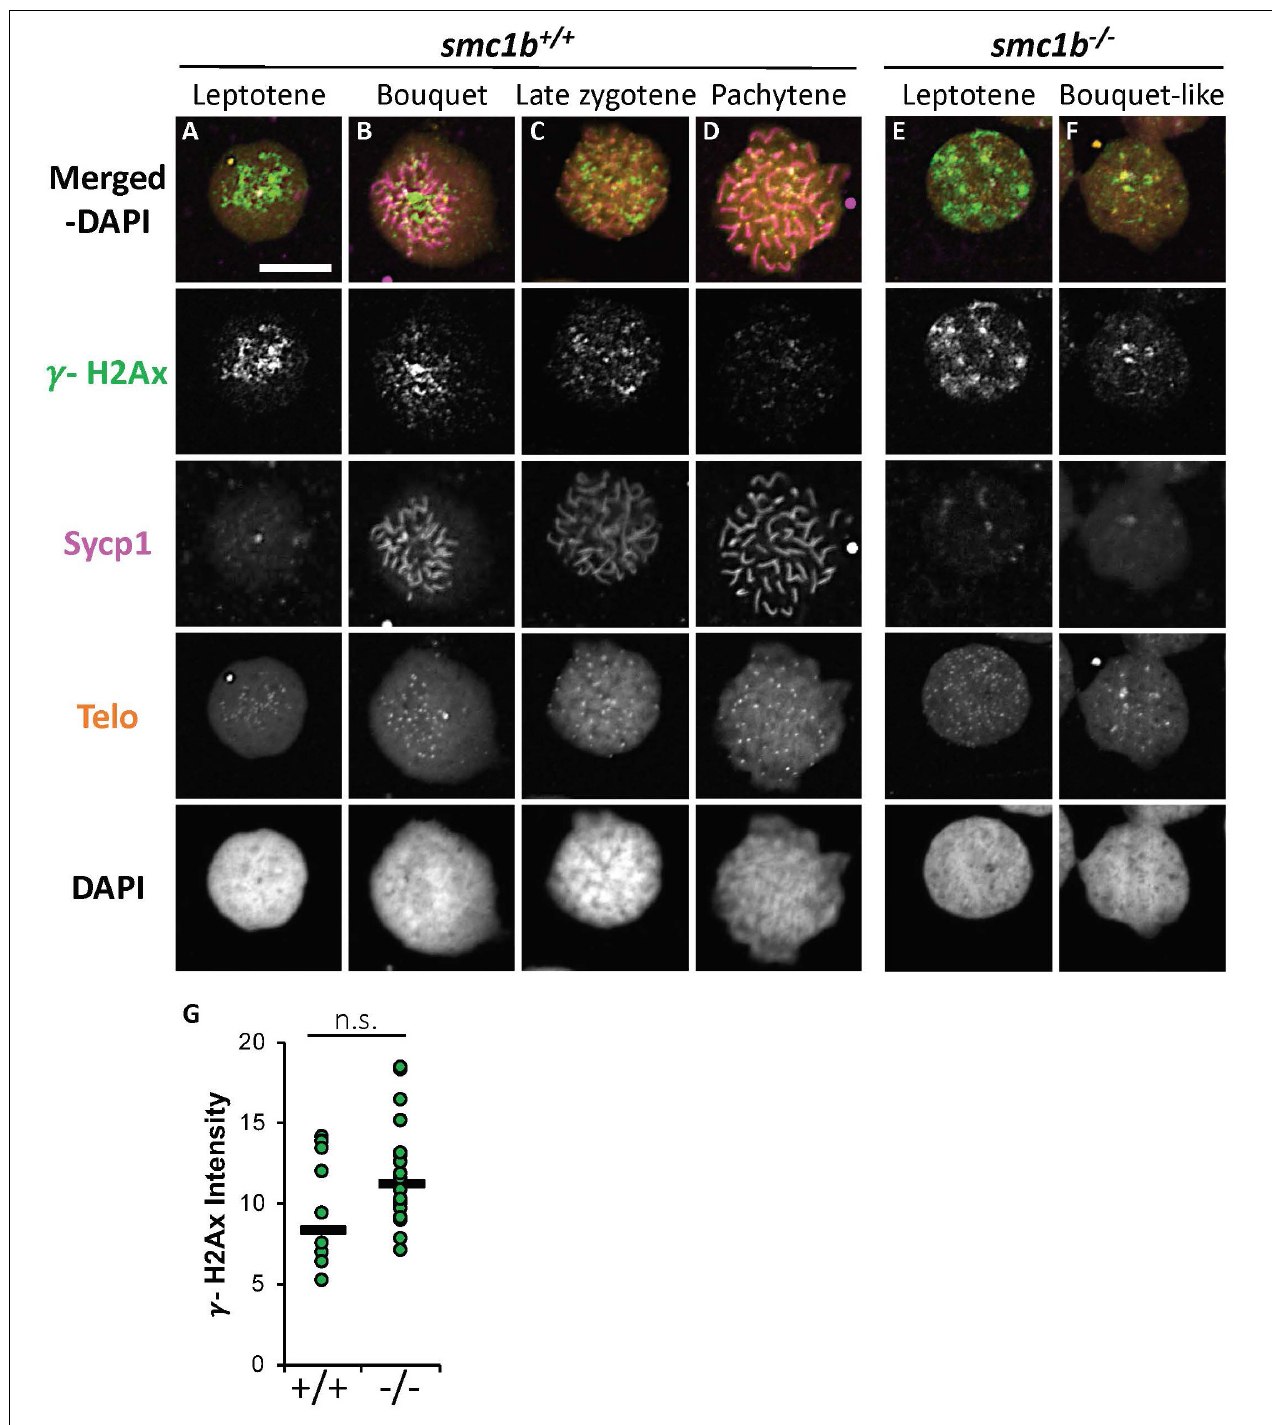
FIGURE 8 | DNA double strand break marker γ -H2Ax was expressed in smc1b Q198X mutant testes. (A–F) Labeling of γ -H2Ax (green), Sycp1 (magenta), and Telo-FISH (orange) on wild-type (A–D) and mutant (E,F) chromosome spreads from testes. γ -H2Ax protein is expressed in both wild-type and mutant nuclei. (G) Quantification of γ -H2Ax fluorescence intensity in wild-type ( N = 10) and mutant ( N = 18) leptotene stage cells shows no statistically significant difference ( P = 0.0945). The horizontal bars show the medians. Scale bar is 10 µ m.